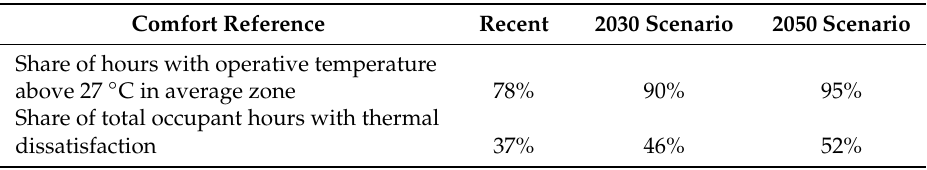
Table 6. Indoor comfort and environmental performances of the building under di ff erent climate